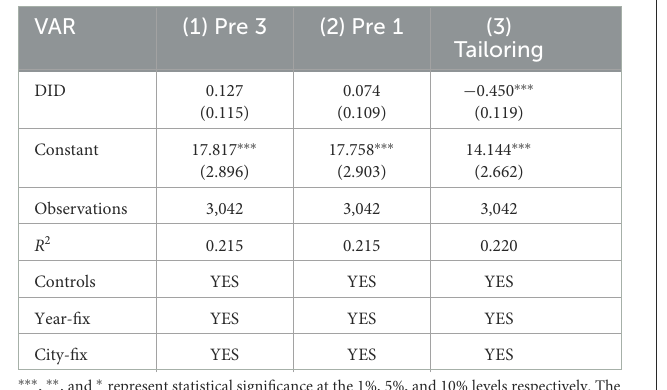
TABLE 3 Results of robustness tests.